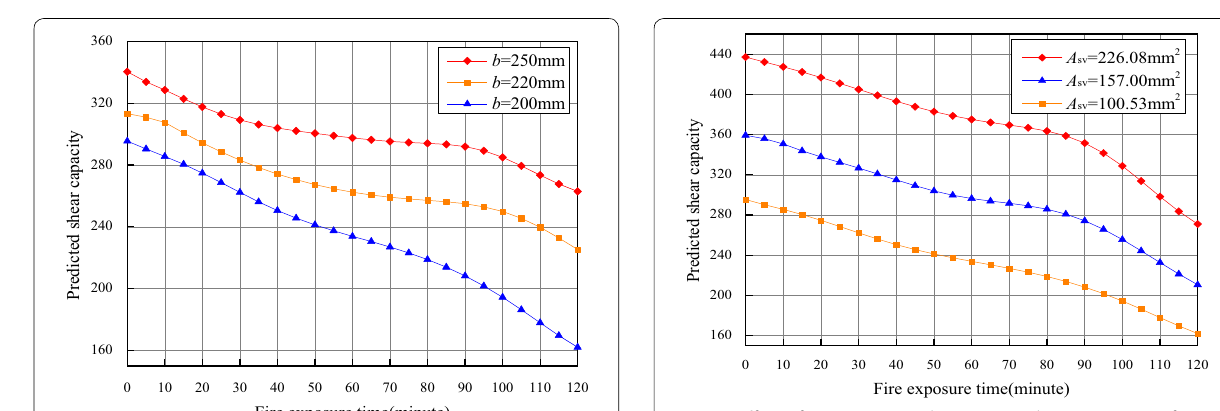
Fig. 10 Effect of stirrup sectional area A sv on shear resistance of